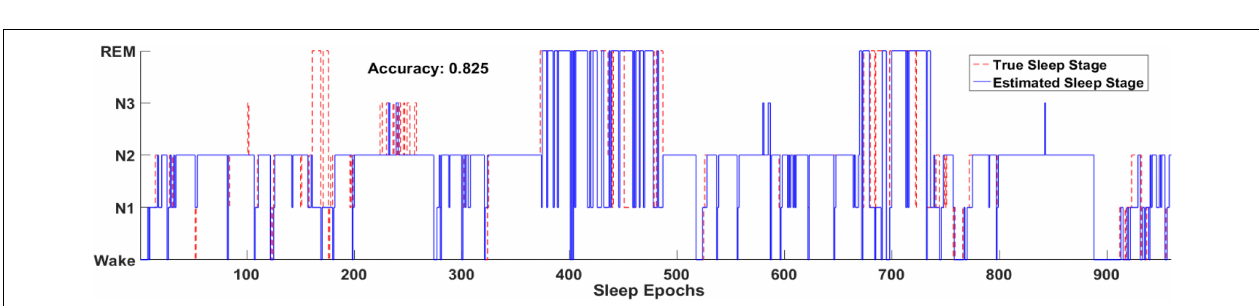
FIGURE 8 | Two full-night hypnograms of one subject. The solid blue line and red dashed line denote the hypnograms depicted by the proposed model and a physician,